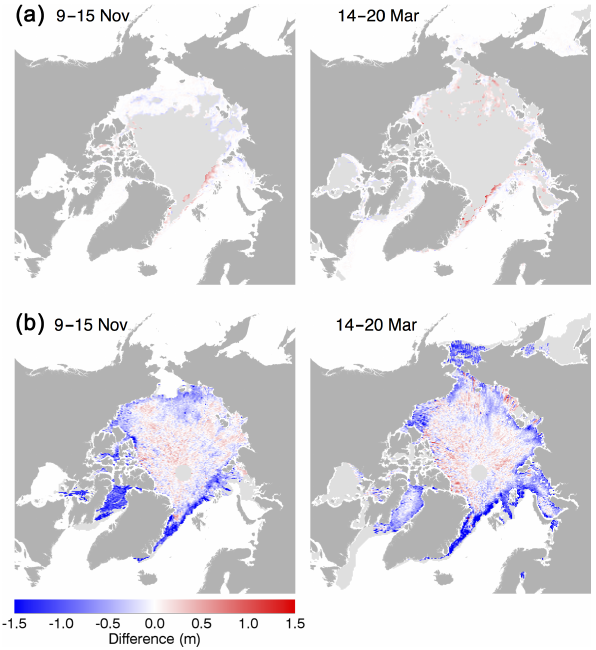
Figure 10. (a) Difference between CS2SMOS and weekly SMOS retrieval for weeks in November 2015 and March 2016. (b) Differ- ence between CS2SMOS thickness for weeks in November 2015 and March 2016 and the corresponding monthly CryoSat-2 thick- ness